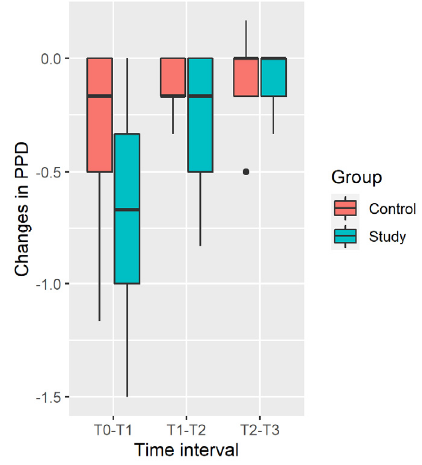
Figure 3. Distribution of changes in PPD.